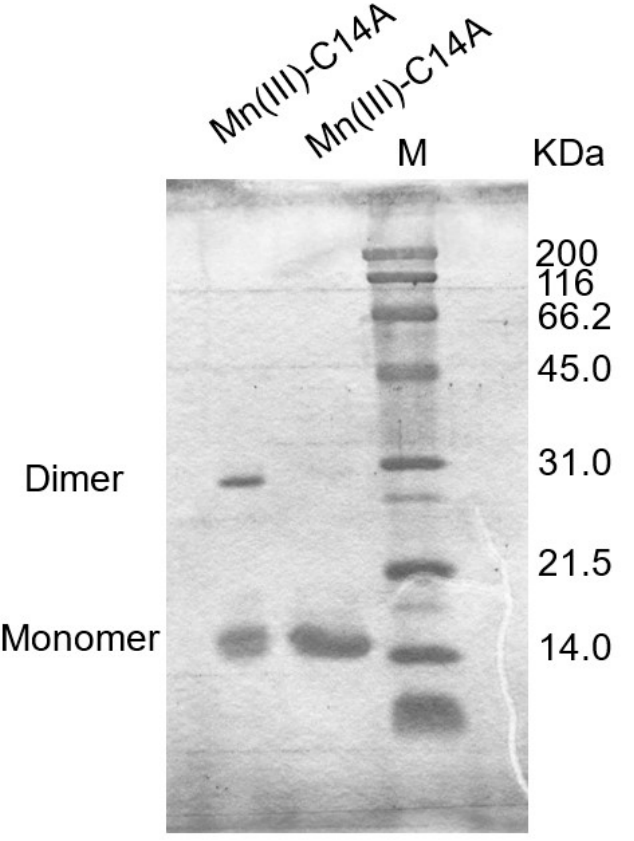
Figure 7. SDS-PAGE (15%) of Mn-C14A after the radical treatment. The Mn(II)-C14A shows a homogeneous band corresponding to the C14A monomer, whereas Mn(III)-C14A shows partial dimer formation. Samples were treated with SDS solution without containing a reducing agent, mercapto-ethanol. M: Protein